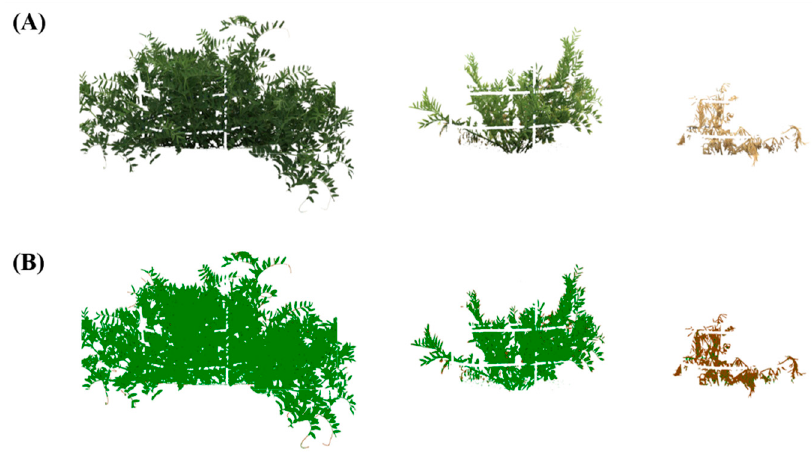
Figure 2. Green and non-green color variation in tolerant to intolerant lentil accessions (left to right) imaged at two weeks after salt application: ( A ) raw images of lentil accessions, and ( B ) processed images of lentil accessions.